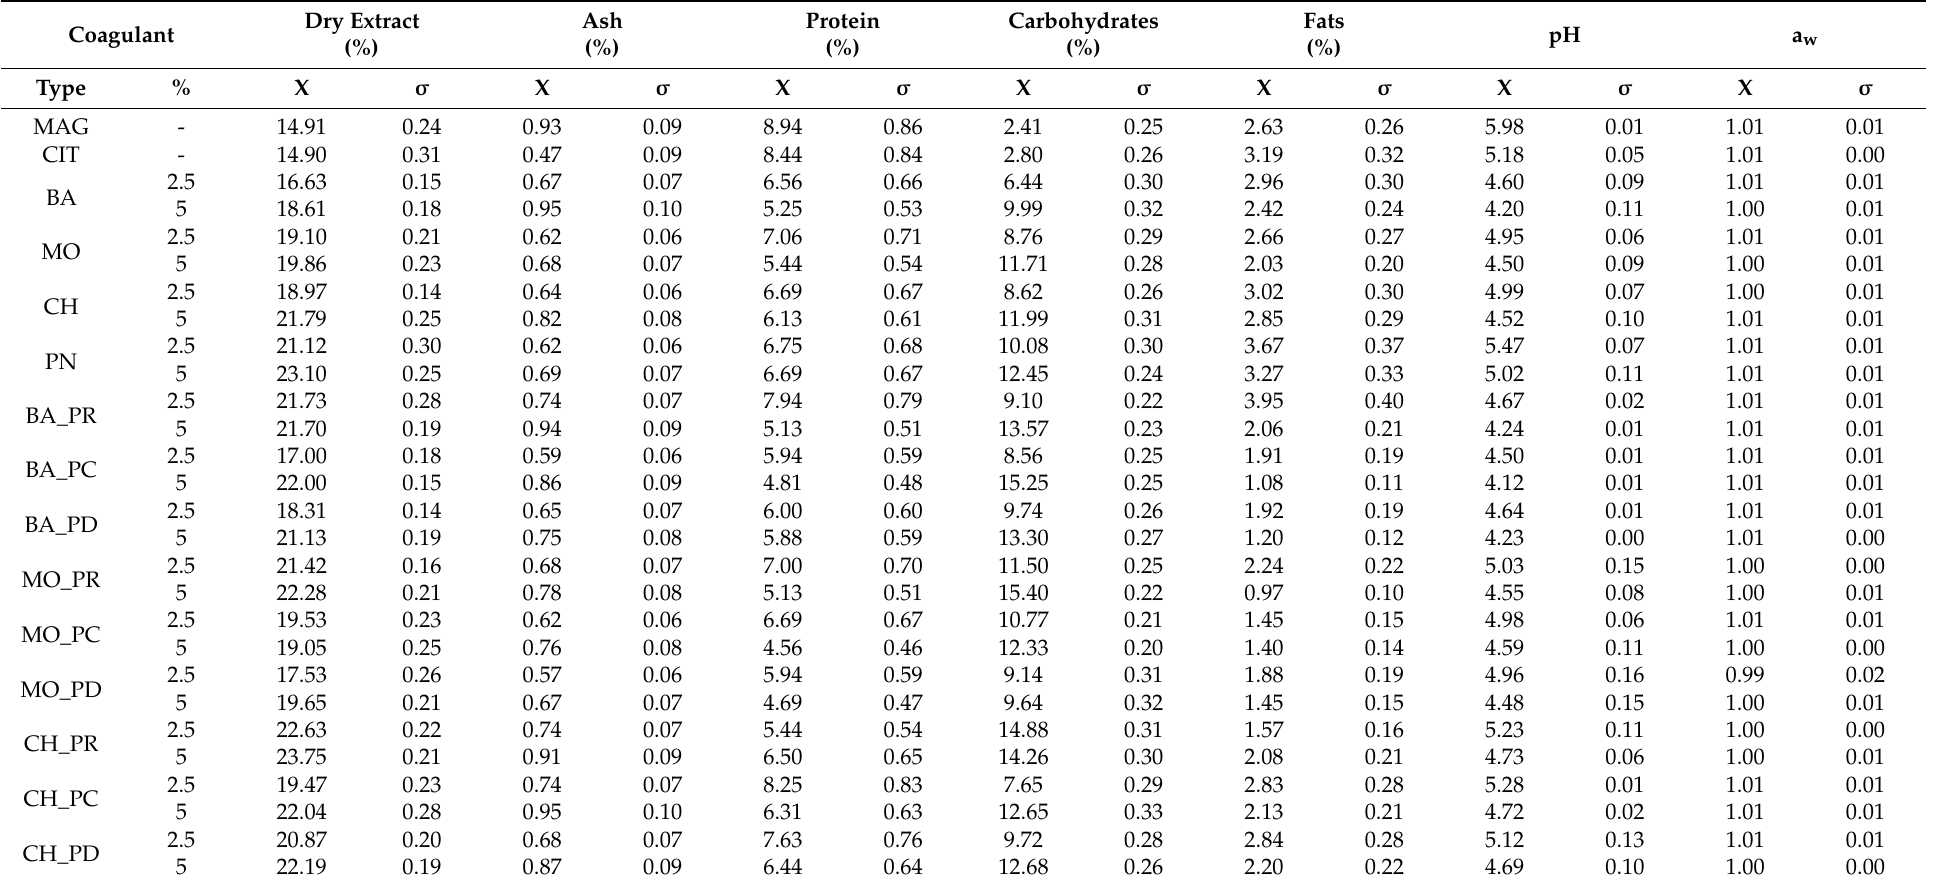
Table 1. Results (X—mean; σ —standard deviation) of the compositional analysis of the tofu samples obtained with the traditional and innovative coagulants at two concentrations (2.5% and 5%) (BA—Barbera; CH—Chardonnay; PN—Pinot Noir; MO—Moscato; MAG—magnesium chloride; CIT—citric acid; PR—pre-distillation; PC—post-distillation continuous; PD—post-distillation